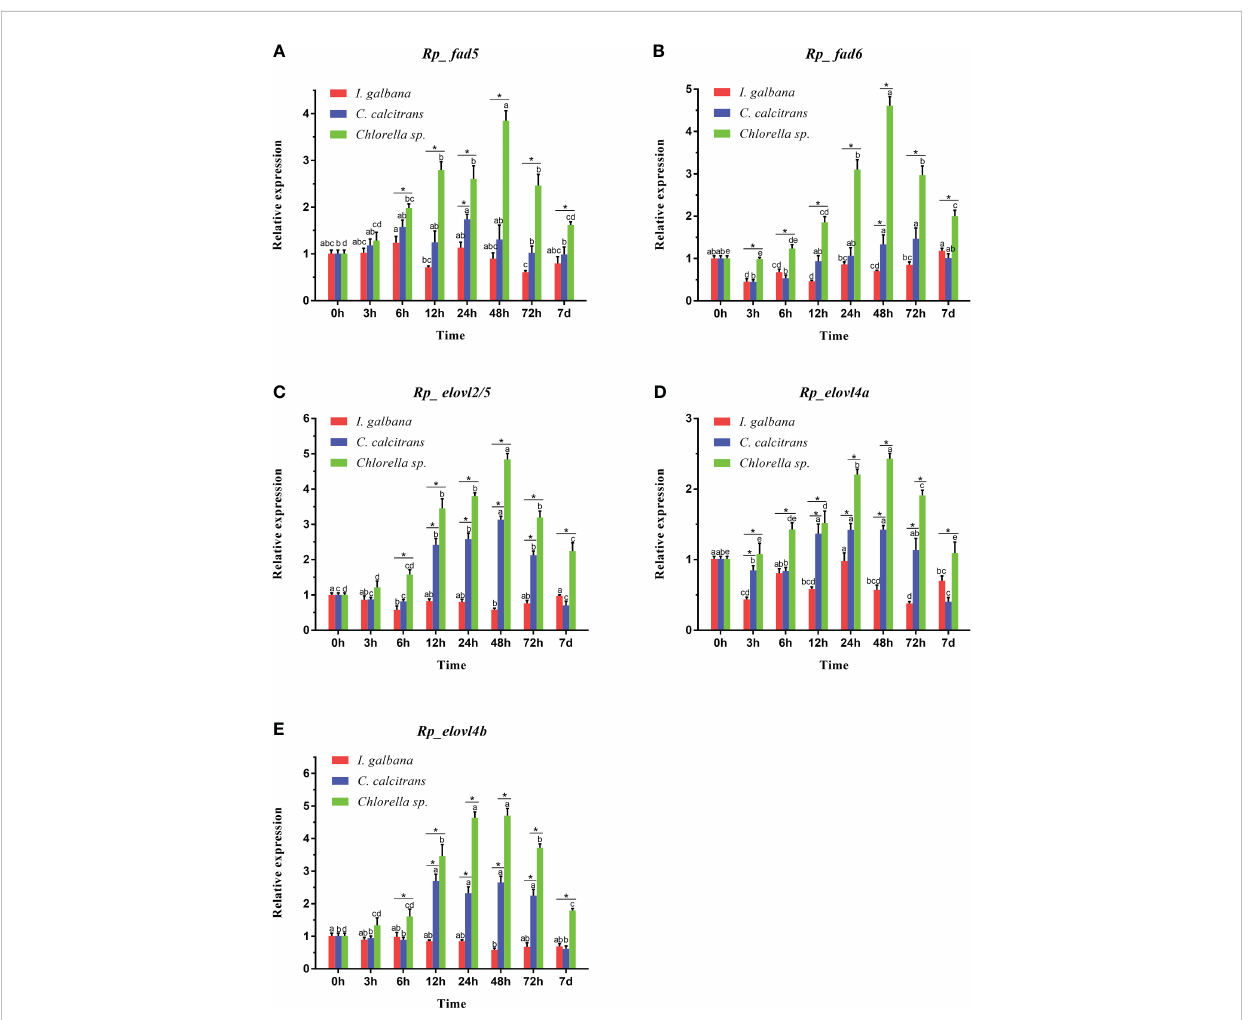
FIGURE 7 Expression patterns of Fad (A, B) and Elovl (C-E) in the visceral mass of R. philippinarum when fed with microalgae diets varied in LC-PUFA composition. Values sharing the common letters on the top of the same color columns are not signi fi cantly different ( P ≥ 0.05). In addition, values at the same sampling timepoint sharing an asterisk are signi fi cantly different ( P <